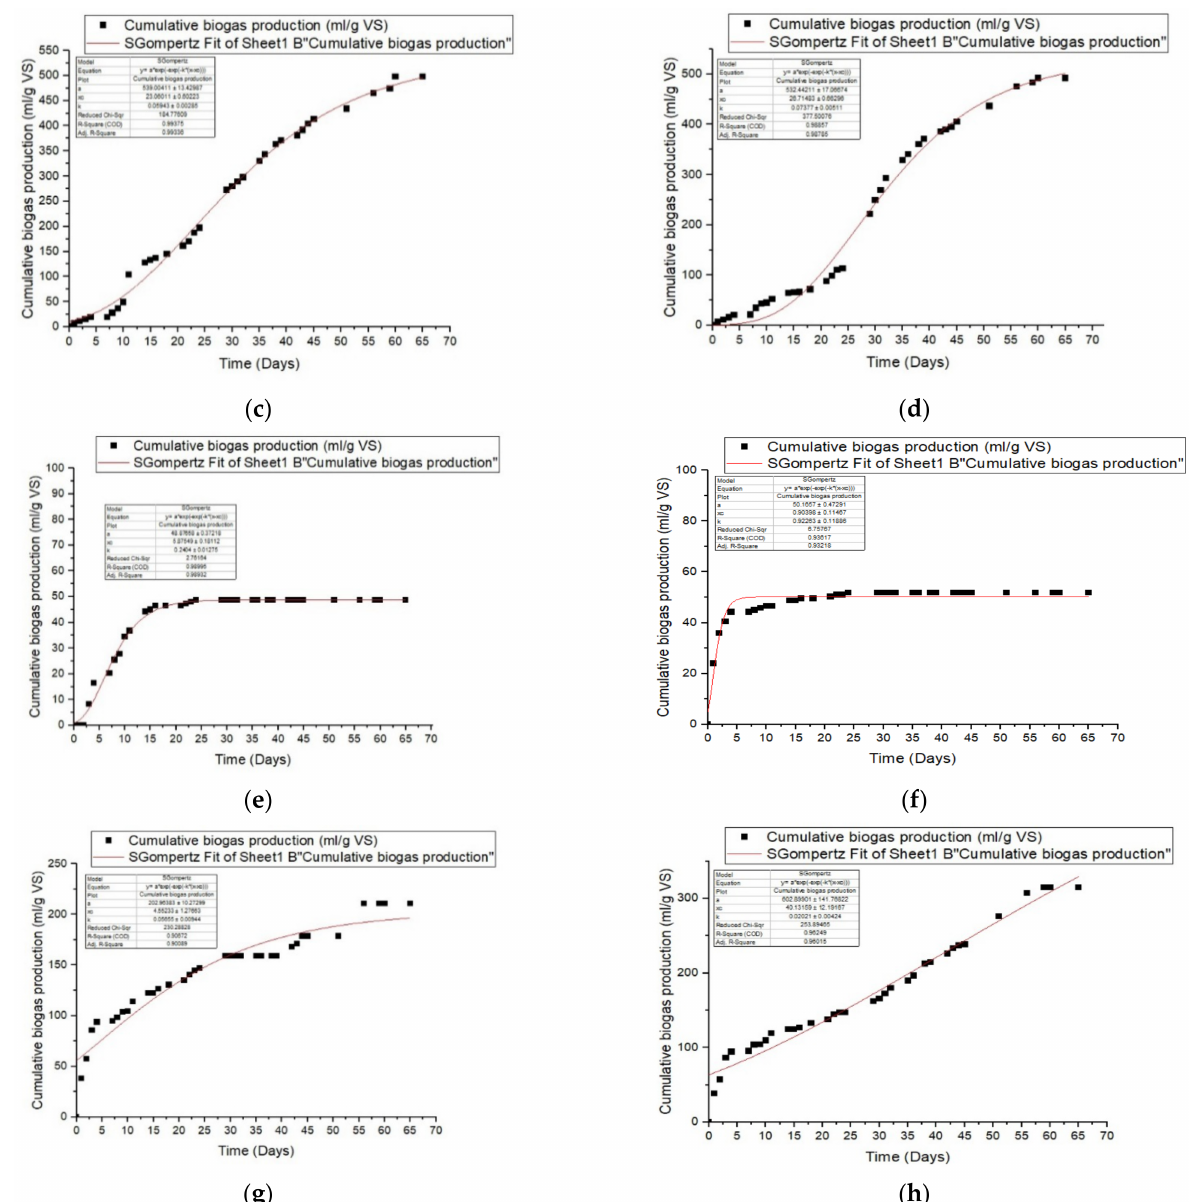
Figure 7. Cumulative biogas yield from Gompertz model, Manure ( a – d ) and Sludge ( e – h ).